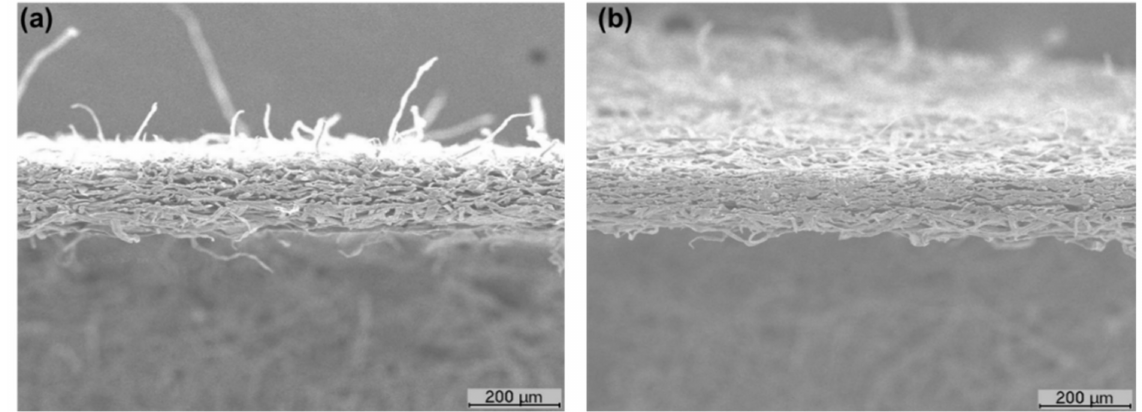
Figure 7. SEM images of the cross-section of the tissue structures prepared with formulation 1 ( a ) and formulation 4 ( b